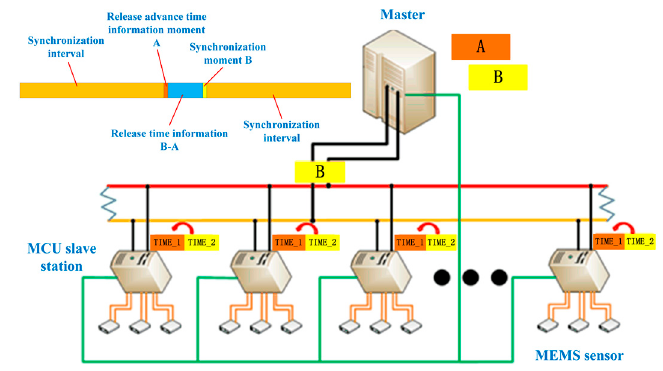
Figure 8. System relative time synchronization principle diagram.